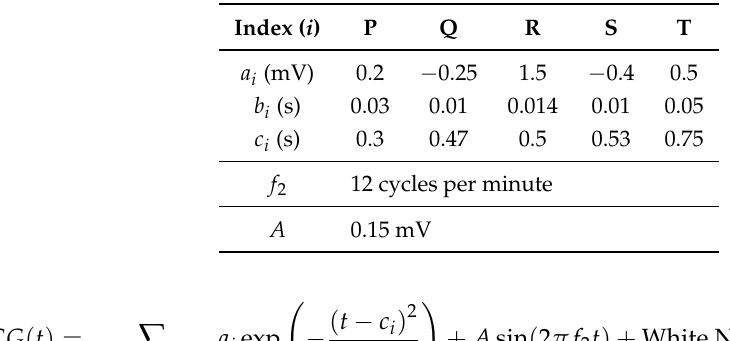
Figure 5. An example of: ( A ) a noisy aECG signal obtained from PhysioNet (adfecgdb) database; ( B ) a noisy synthetic aECG signal simulated in LabVIEW using the Bio-Physiological Signal Generator (BPSG) virtual instrument. Table 1. Maternal ECG (mECG) model